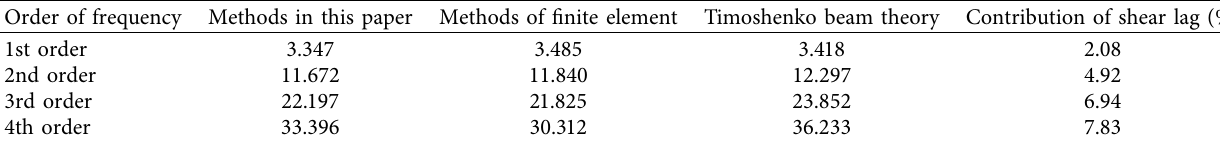
Figure 4: Finite element model for composite box girder. Table 1: Comparison of vibration frequency values of composite box girder (Hz).